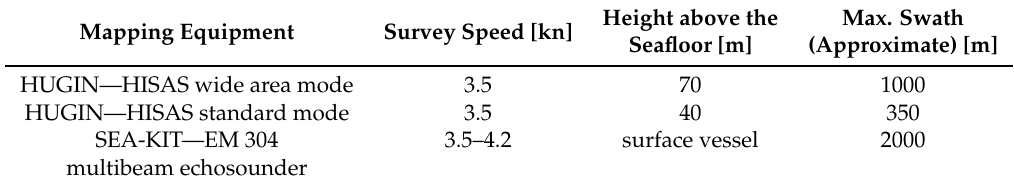
Table 5. Main parameters affecting the survey performance and mission